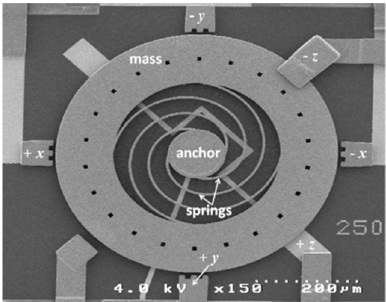
Figure 2. A switch with six fixed contact-point electrodes positioned in the ±x, ±y, and ±z directions for triaxial sensitivity [3].